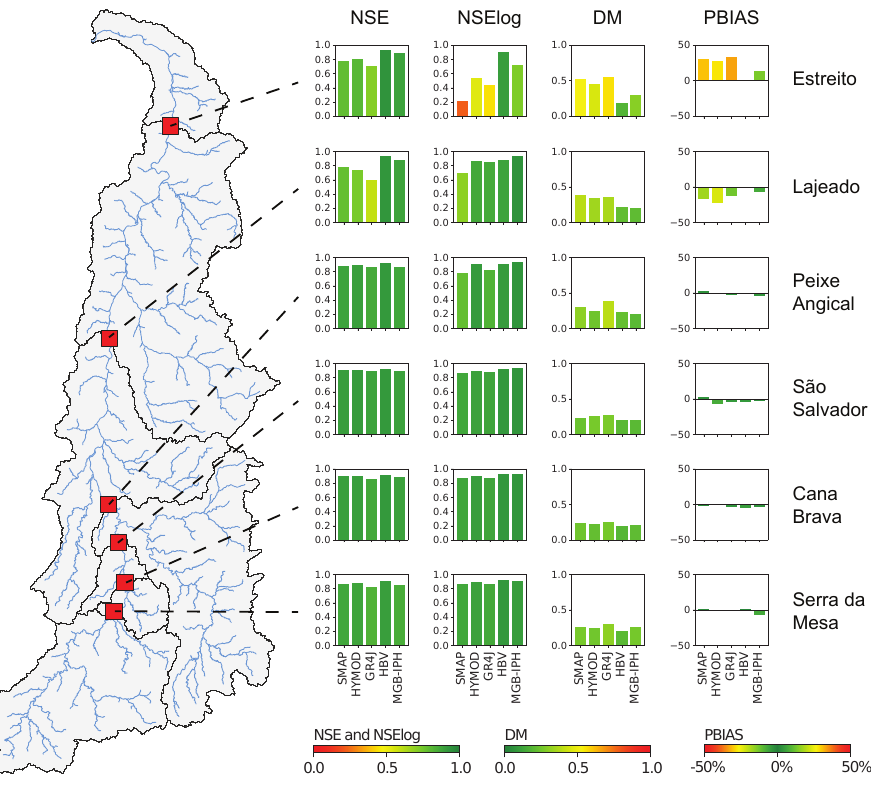
Figure 8. Results of deterministric metrics in the calibration